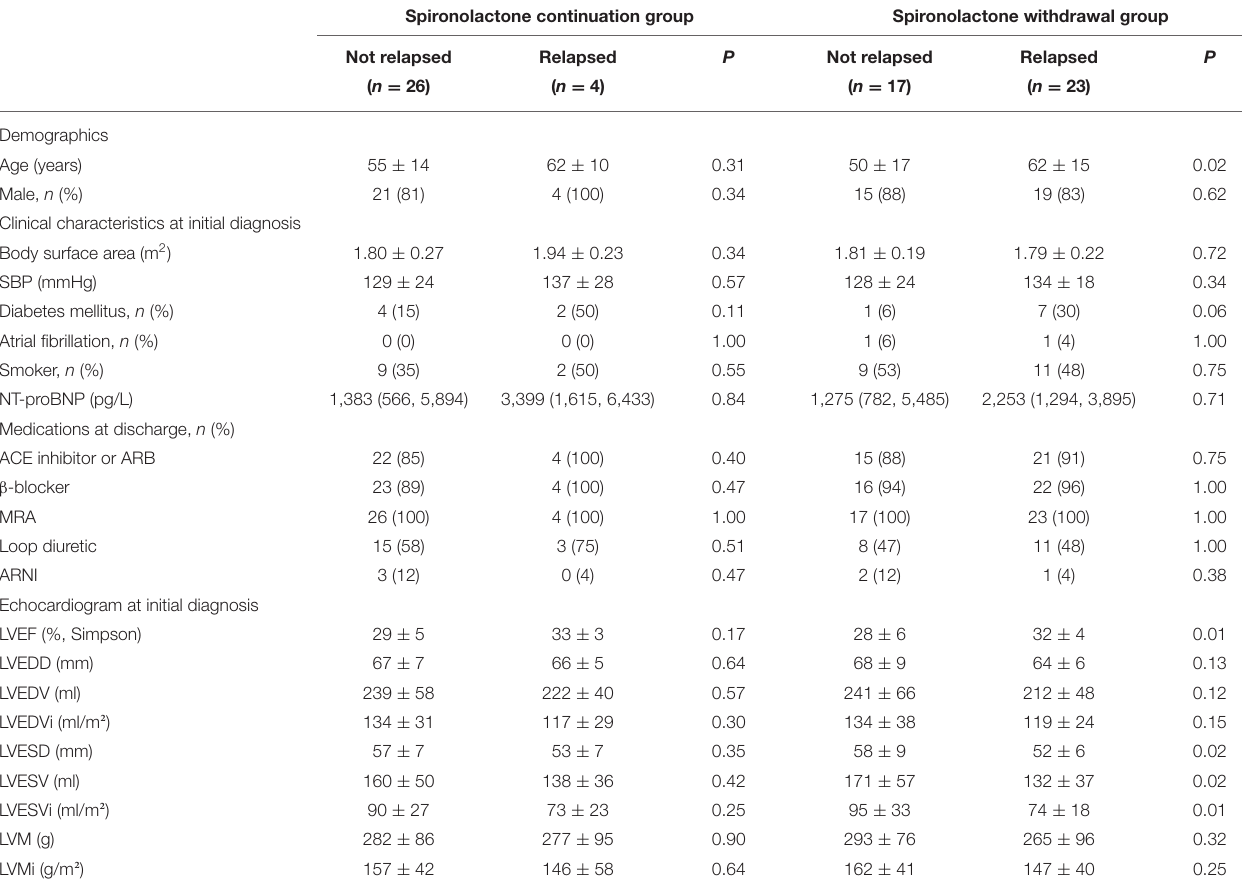
TABLE 2 | Baseline characteristics grouped by endpoint status. Spironolactone continuation group Spironolactone withdrawal